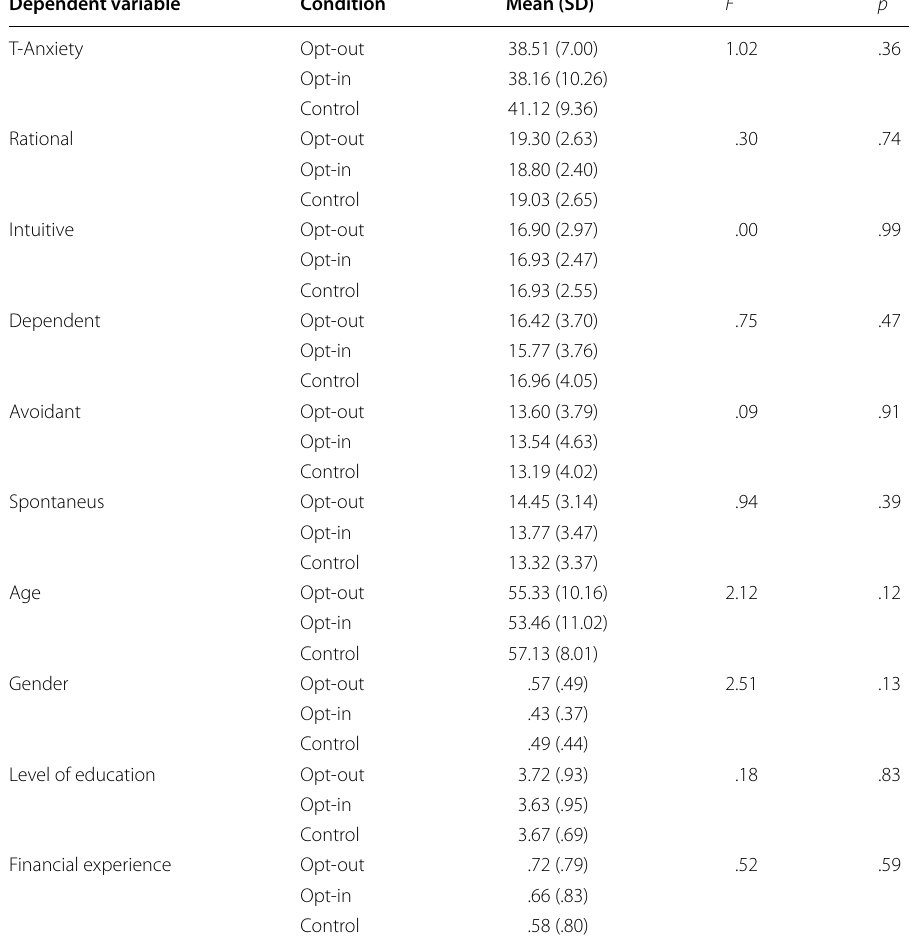
Table 1 Descriptives and statistical comparisons among the three experimental groups regarding demographics and experience in the financial field